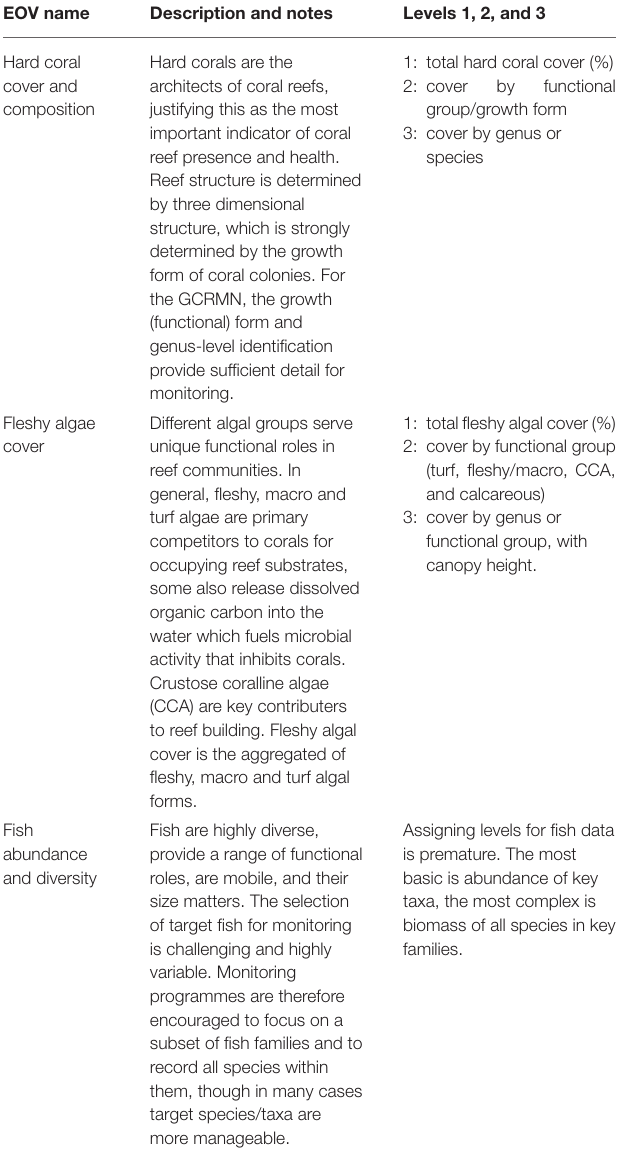
TABLE 3 | Essential Ocean Variables (EOVs) important for monitoring and reporting coral reef health, and levels proposed to assist in assessing data quality by the Global Coral Reef Monitoring Network